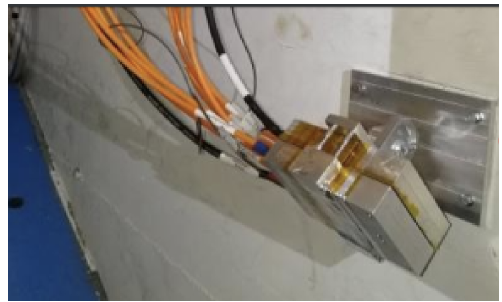
Figure 3. Timepix3 (TPX3) hodoscope using two TPX3 sensors, operated at LHC Run-2. The device was mounted in the ATLAS experiment cavern at